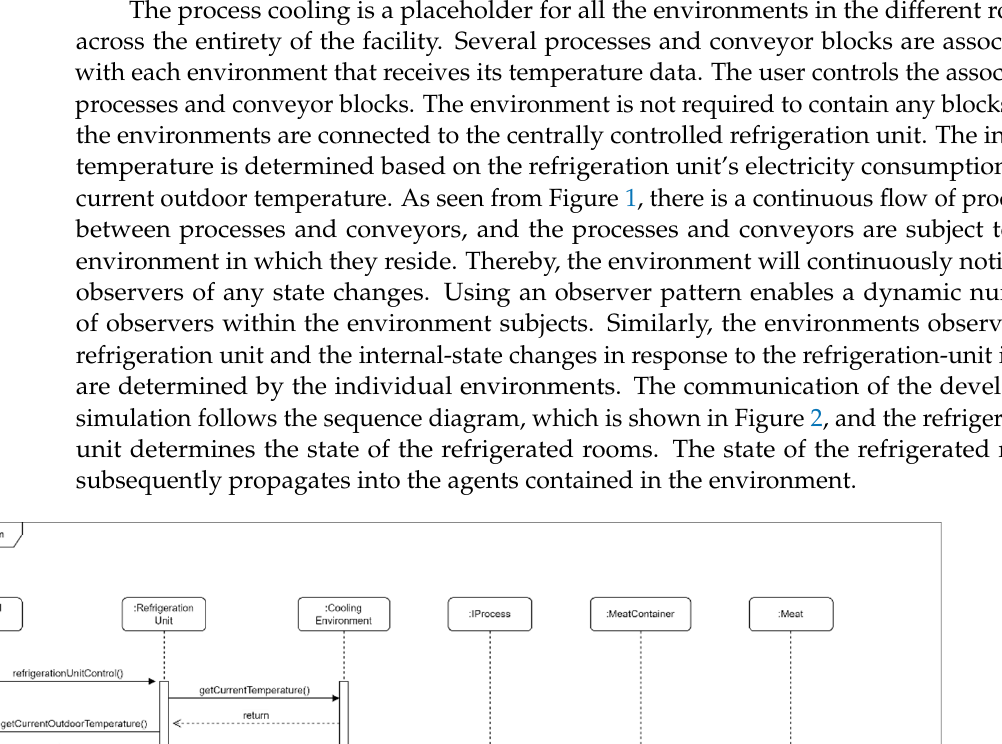
Figure 1. The simulation architecture.